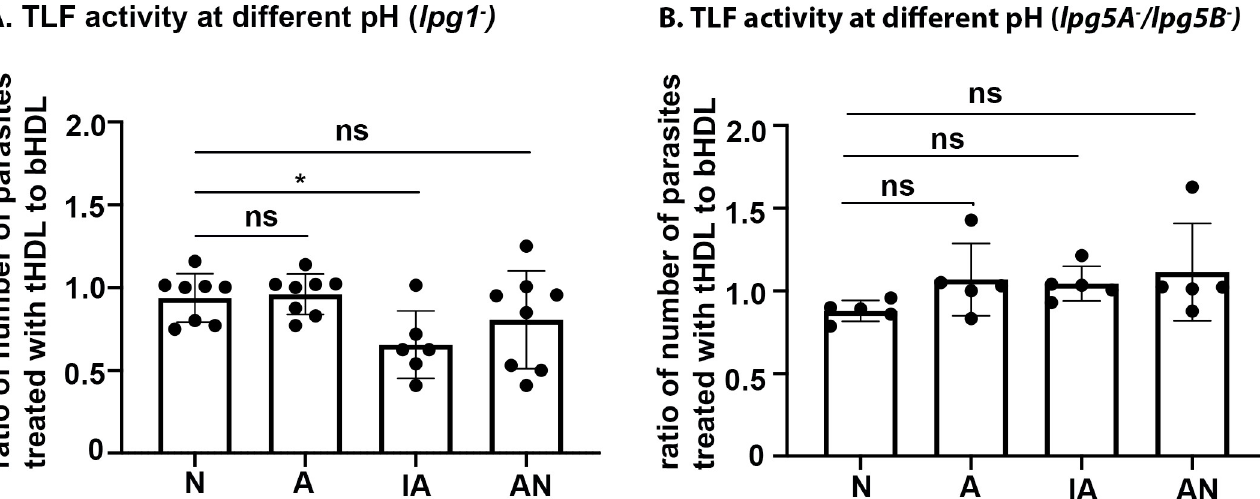
Fig 6. Resistance of surface glycoconjugate mutants to TLF activity is not due to variations in phagosomal pH. Metacyclic promastigotes of the glycoconjugate mutants A. lpg1 - and B. lpg5A - /lpg5B - were treated with human HDL (tHDL, 1.5 mg/ml) or bovine HDL (bHDL, 1.5 mg/ml) and incubated in Neutral—N pH 7.4 for 2hours, Acidic–A pH 5.6 for 2 hours, Increased acidification- IA pH 5.6 for 1 hour followed by pH 4.5 for 1 hour, and Acid and Neutral- AN pH 5.6 for 1 hour followed by pH 7.4 for 1 hour. Parasites were microscopically counted using a hemocytometer. The y-axis represents the ratio of parasites resulting from tHDL treatment compared to bHDL treatment. The data represents the Mean ± standard deviation (SD) of three experiments that have been combined. � p < 0.05, ns- non-significant, ANOVA test, multiple comparison with Bonferroni correction.